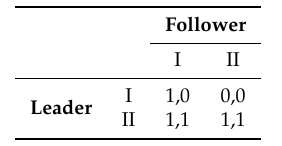
Table 5. Leader behaves in a friendly way when her follower is also